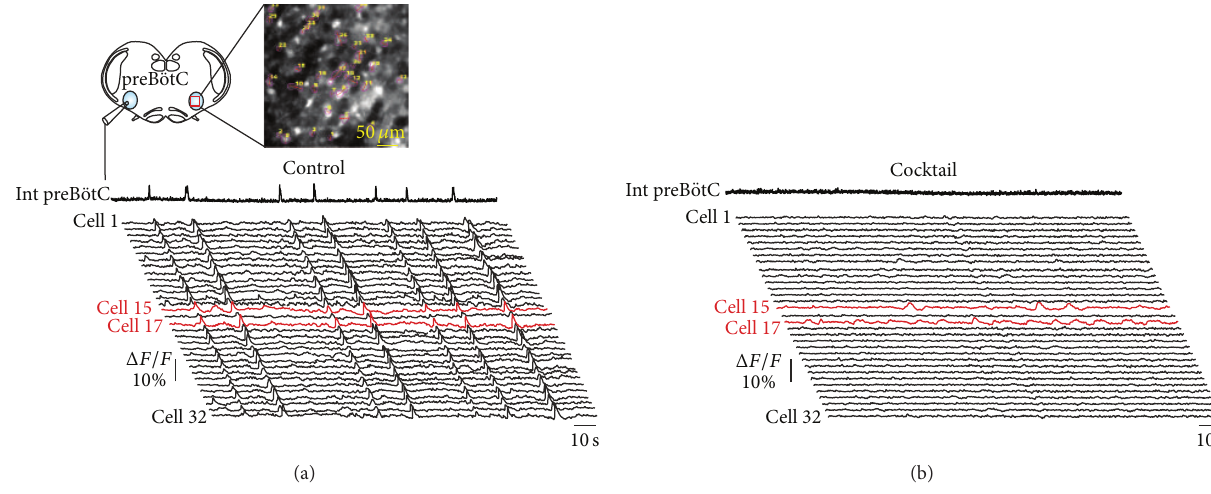
Figure 3: Detection of pacemaker neurons in the embryonic respiratory network. (a) Top: schematic of an embryonic transverse brainstem slice used for extracellular electrode recording from the isolated preB¨otC network on one side and calcium imaging of the contralateral preB¨otC network. The fluorescent image is an example where 32 preB¨otC cells expressed calcium transients simultaneously and in phase with the whole network. Bottom: simultaneous recordings of network electrophysiological activity (Int preB¨otC, top) and calcium transients ( Δ𝐹 / 𝐹 ) in individual cells numbered 1–32 from top to bottom. All selected cells displayed fluorescent changes in phase with inspiratory bursts monitored at thenetwork level. (b)Same recordings after blockade ofchemical synapses within thenetwork by exposureto a cocktail of 20 𝜇 M CNQX, 10 𝜇 M AP5, 10 𝜇 M bicuculline, and 1 𝜇 M strychnine. The majority of cells fell inactive (black traces), but a few neurons remained capable of generating spontaneous rhythmic fluorescent changes (red traces). These cells were thus identified as preB¨otC pacemaker